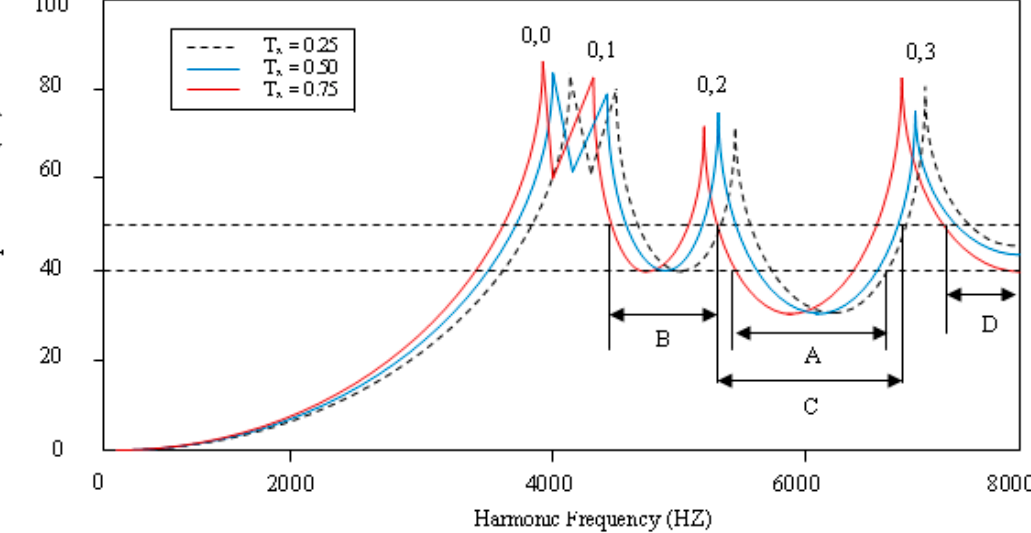
Figure 10. Numerical comparison of sound power level for annular plate attached with 1 rectangular stiffener patch and having parabolic decreasing thickness variations (Case I) for different taper ratios T x .